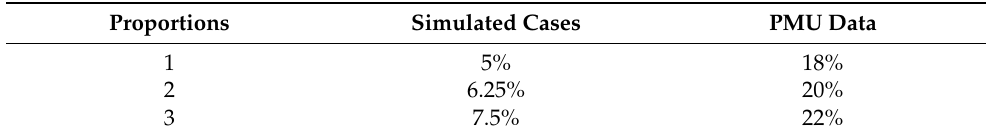
Table 2. Time series proportion used in the models’f training.